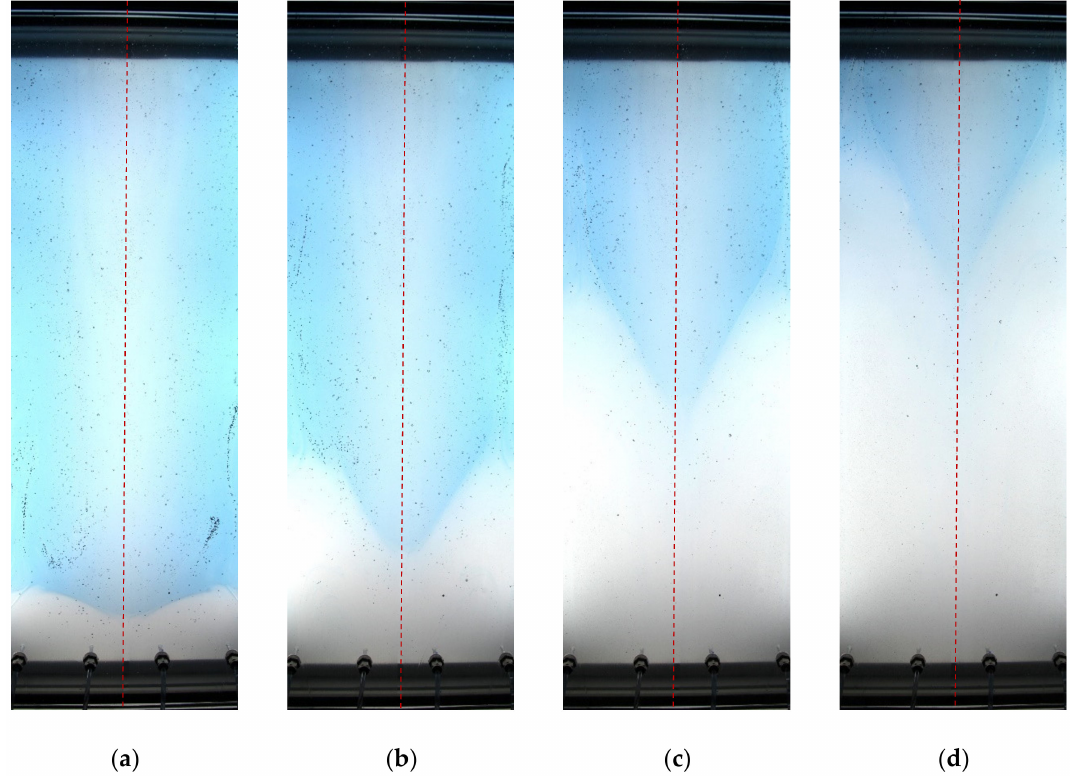
Figure 11. Snapshots of displacement flow in test no. 6. ( a ) t = 0 s; ( b ) t = 4 s; ( c ) t = 9 s; ( d ) t = 13